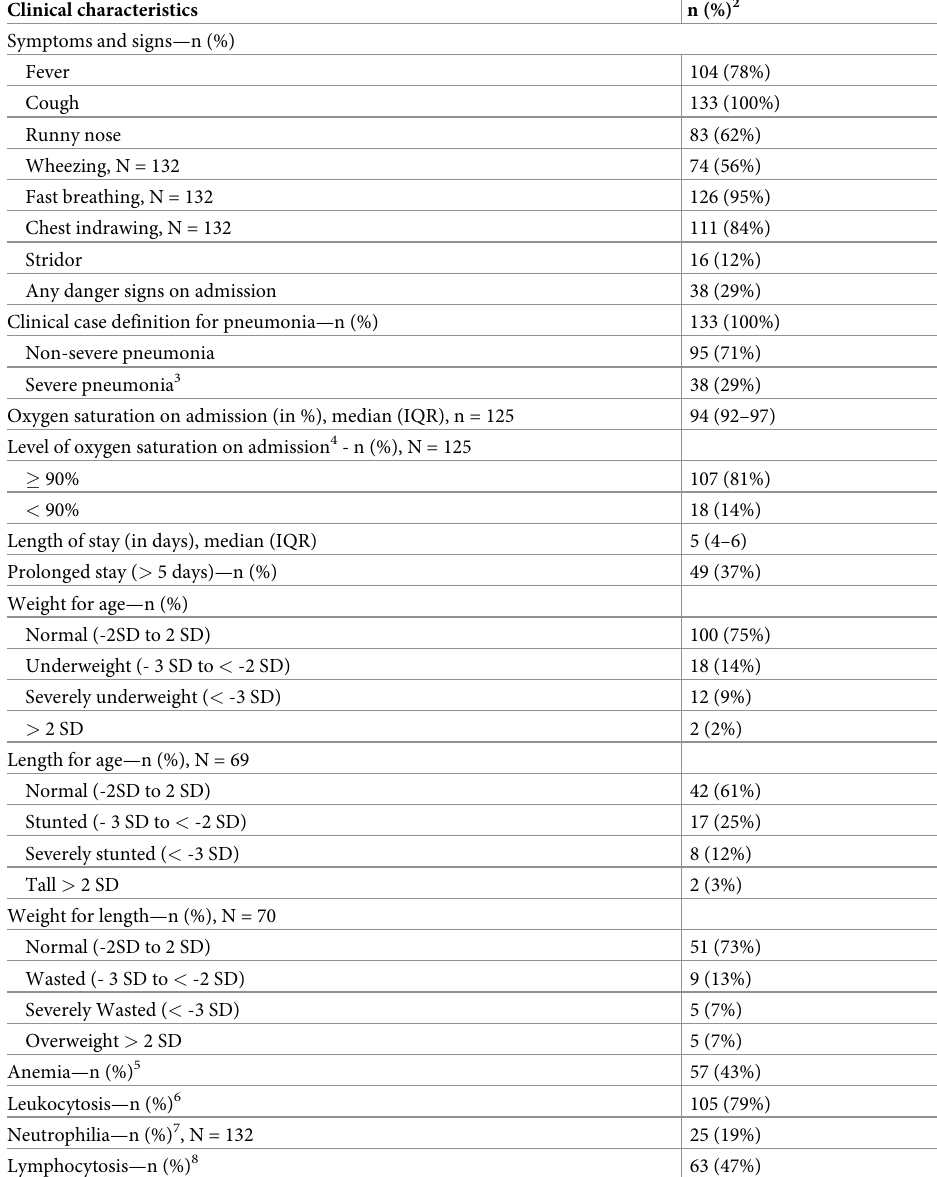
Table 2. Clinical characteristics and laboratory profiles of participants (n = 133) 1 . Clinical